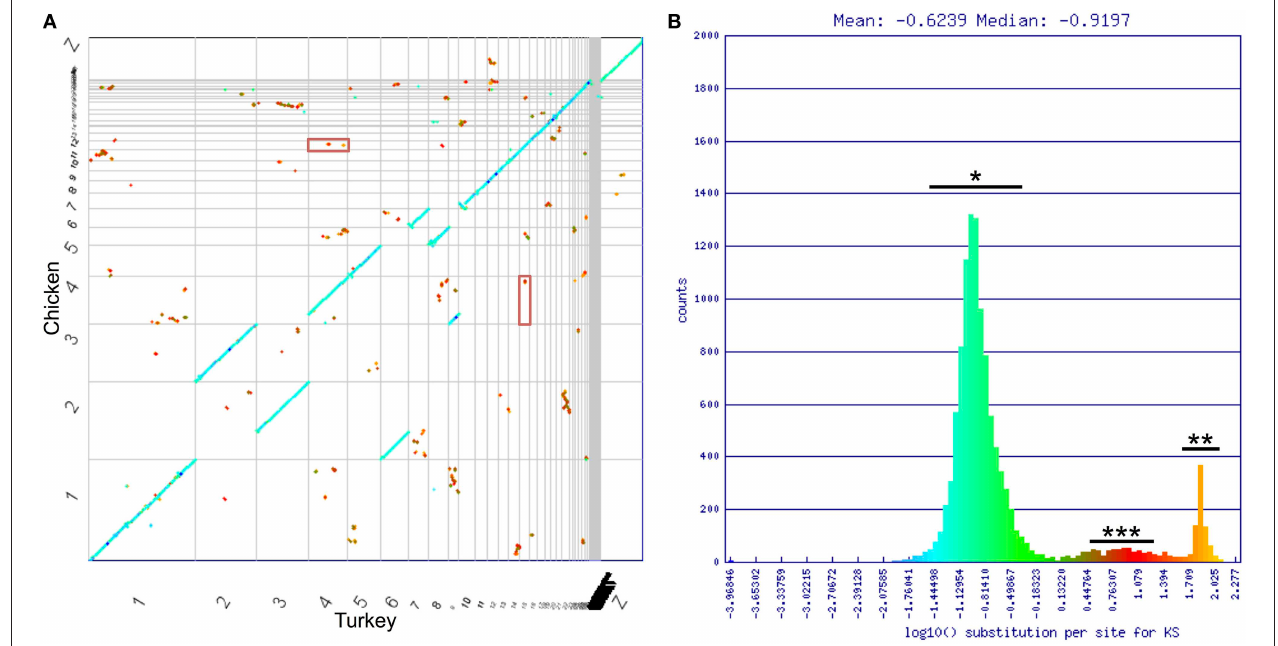
FIGURE 5 | Chicken/turkey synonymous dot plot. (A) Syntenic dot plot of Chicken (Y-axis) and Turkey (X-axis) genomes. Horizontal or vertical gray lines delineate chromosomes. Each dot represents an orthologous gene pair. Dots are colored based on synonymous mutation rate (Ks) as calculated between each orthologous gene pair. (B) Histogram of log 10 transformed Ks values. Three major groupings of Ks values can be identified. Blue/Green is typical of orthologous genes derived from the divergence of lineages ( * ). Orange is algorithmic noise ( ** ; Ks values > 80 substitutions per synonymous site). Small red group is indicative of an ancient whole genome duplication event ( *** ). DRD1A/DRD1B genes fall within this latter cluster, and are shown in the red boxes in (A) . Analysis can be regenerated at https://